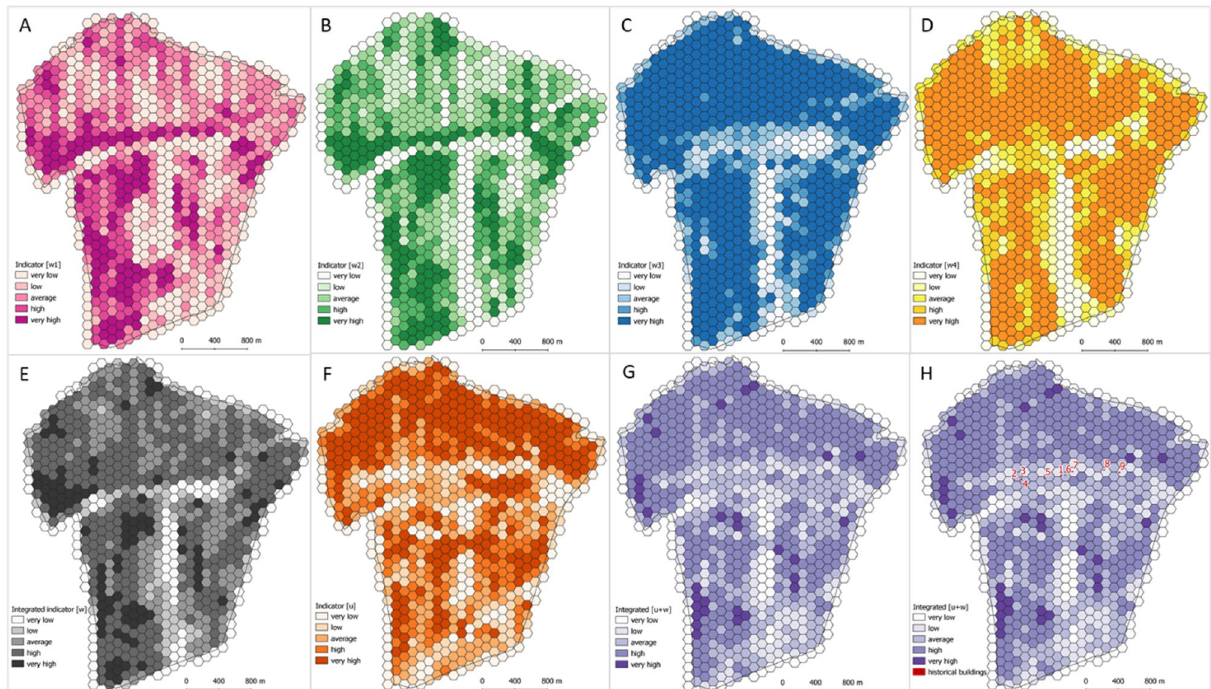
Figure 7. Spatial variation in the persistence of component indices. ( A ) w 1 index; ( B ) w 2 ; ( C ) w 3 ; ( D ) w 4 , ( E ) land structure persistence integrated index ( w ); ( F ) Land-use structure persistence index u; ( G ) land structure